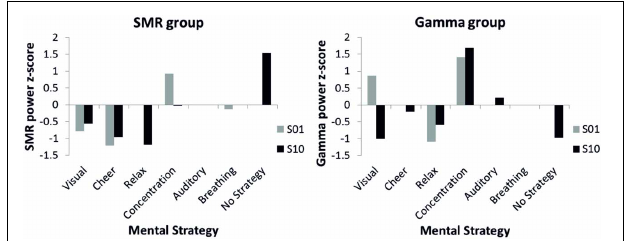
FIGURE 5 | Z -transformed SMR power for the SMR group (left panel) and z -transformed Gamma power for the Gamma group (right panel) during first (gray bars) and tenth (black bars) NF training session, presented separately for different mental strategies used to control one’s own EEG signal. Note that no error bars are plotted since only single participants were present in several categories. participants reported to use different types of mental